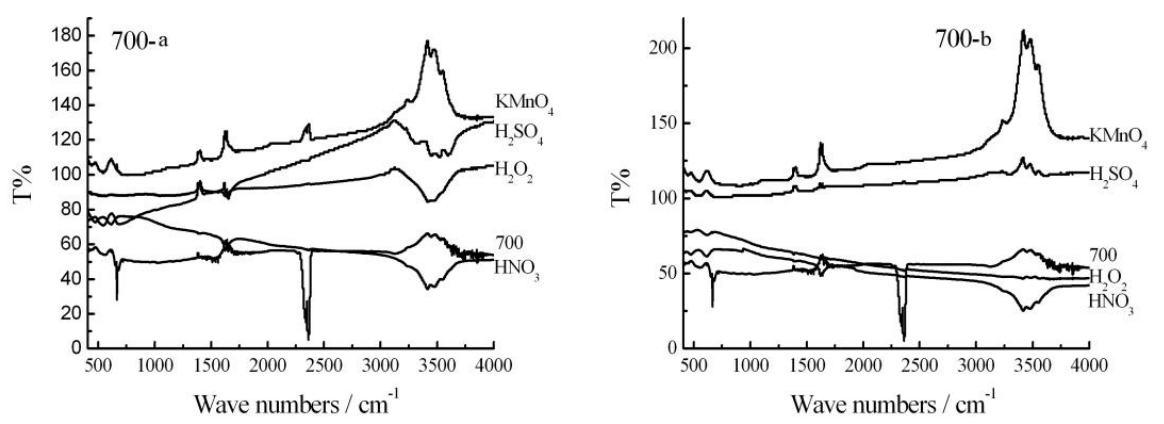
Figure 3: FTIR spectra of biochar obtained at 700 o C before and after modification (a. Dipping, b. Ultrasonic dipping).